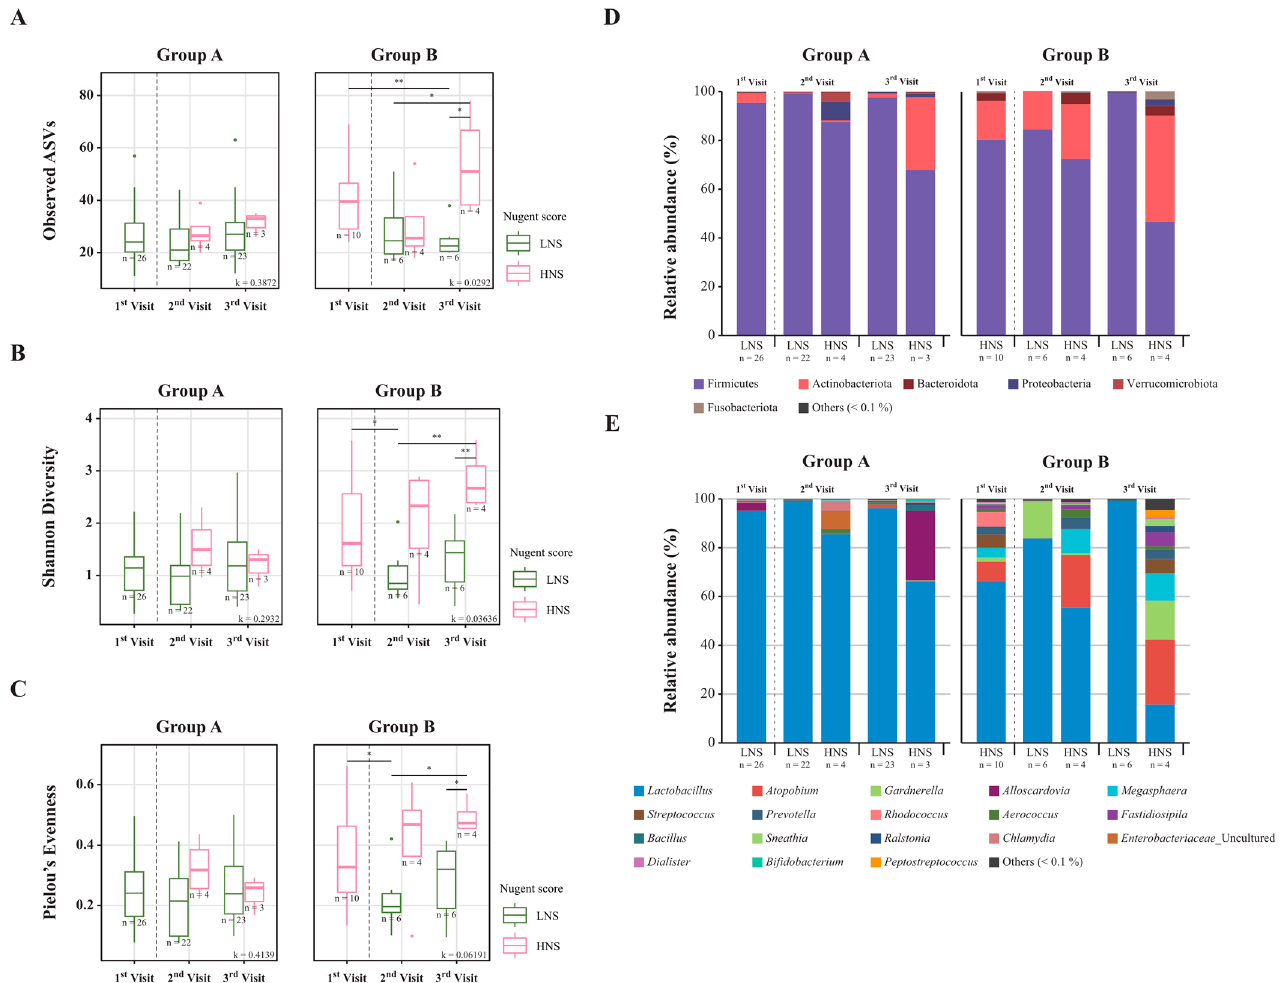
Figure 2. Changes in alpha diversity and taxonomy composition for each visit in the two groups divided by the Nugent score of the first visit. Boxplot showing ( A ) observed amplicon sequence variants (ASVs), ( B ) Shannon diversity, and ( C ) Pielou’s evenness in Group A and B. Relative abundance at the ( D ) phylum and ( E ) genus levels in Group A and B. Each group was classified as LNS or HNS based on the NS at the first visit. * p < 0.05, ** p < 0.01 (Wilcoxon rank-sum test). An average of <1% was labeled as other.